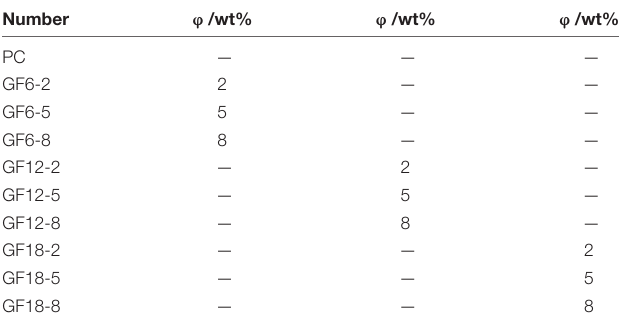
TABLE 1 | Fiber content of each type of fine-grained concrete.